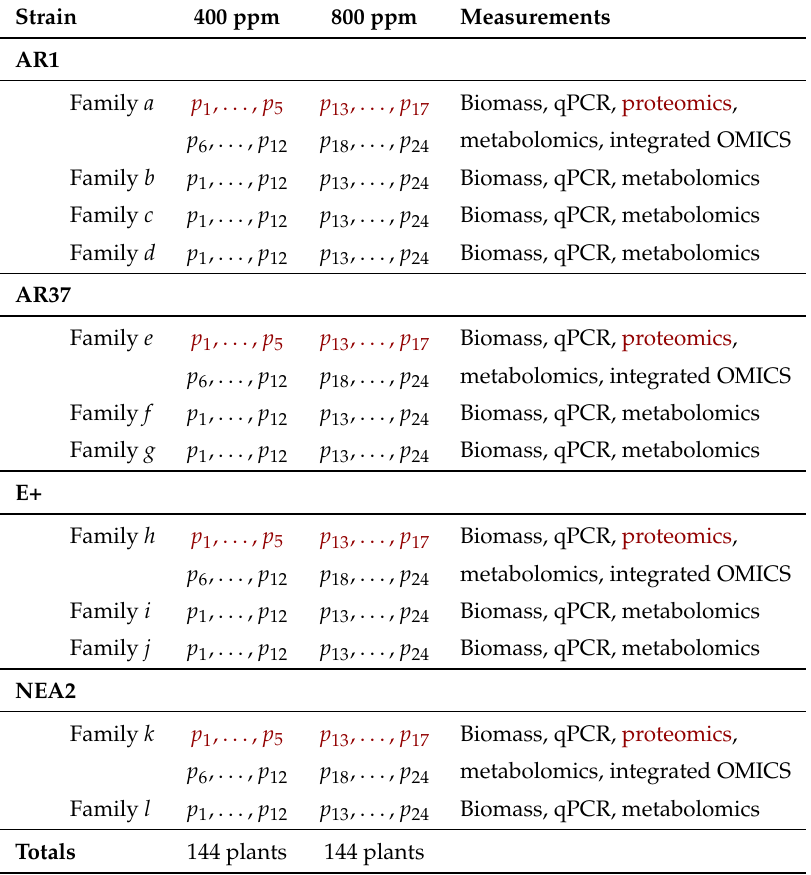
Table 1. Sample size of plants nested in family, nested in endophyte strain. There were 288 plants in total, 144 in each of the two levels of CO 2 . Within a family there are 24 plants, 12 in each level of CO 2 . The families are replicated in each level of CO 2 . For the proteome analysis we used 5 of the 12 plants in each level of CO 2 from a single family per endophyte strain; these are denoted with the red font. Strain 400 ppm 800